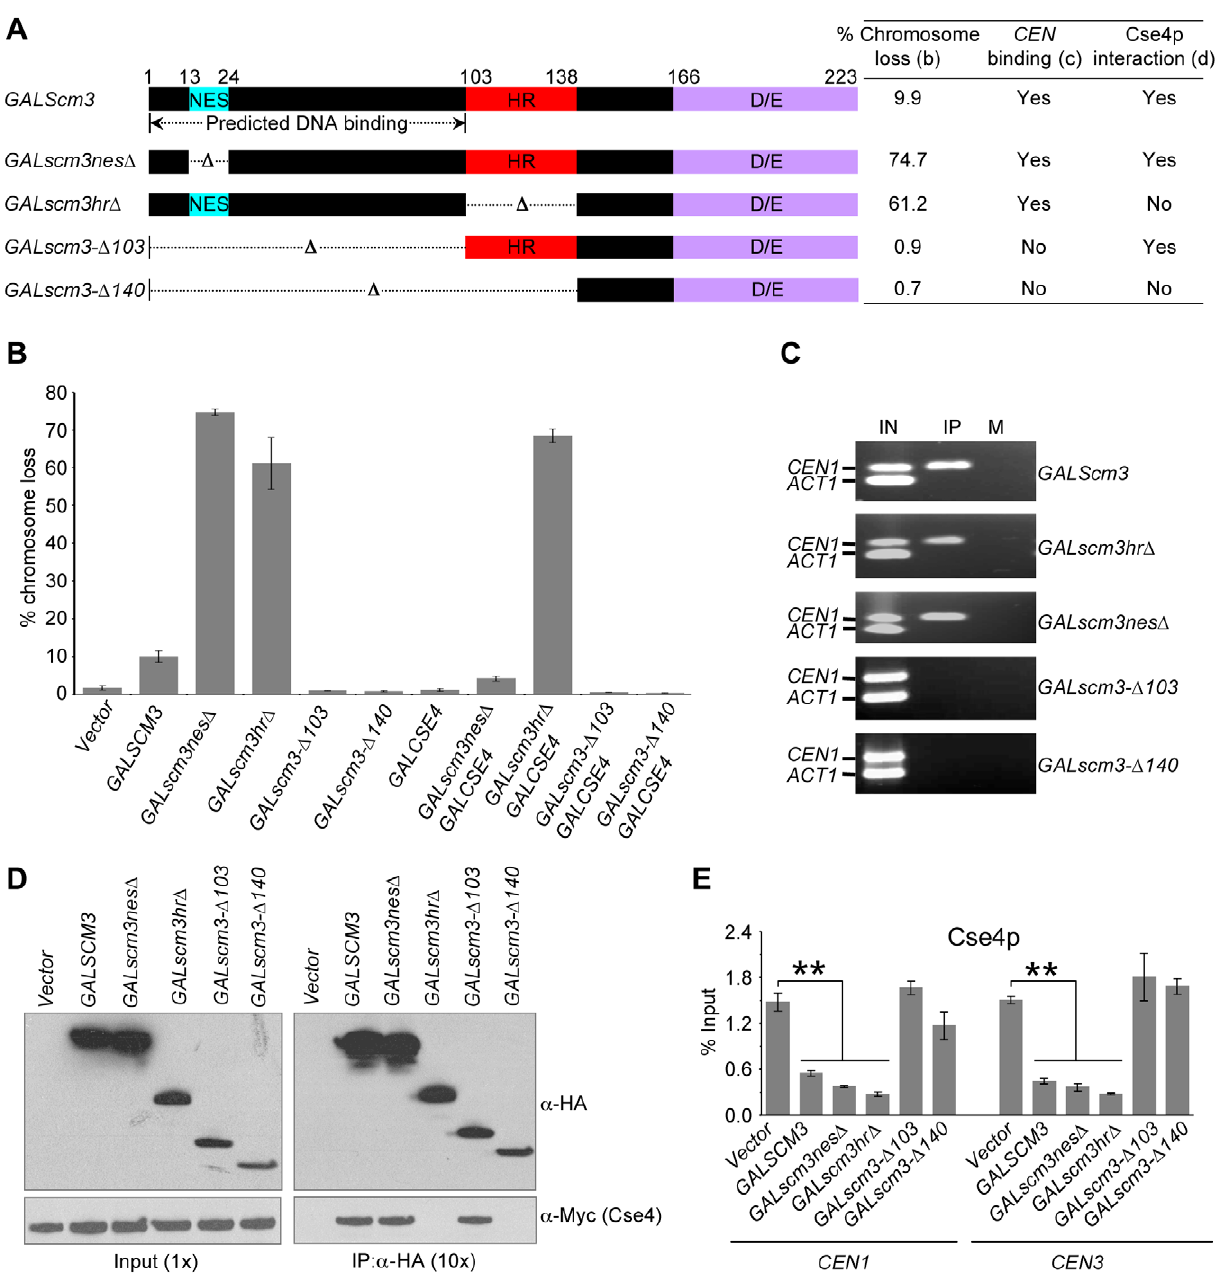
Figure 5. Scm3p can associate with CEN DNA independently of Cse4p, and the N-terminus of Scm3p mediates its centromeric association. (A) Schematic of full-length Scm3p and its allelic mutant proteins constructed using gene deletion approach. NES: nuclear export signal; HR: heptad repeat; and D/E: C-terminus acidic domain. Results from chromosome loss (B), CEN -binding (C) and Cse4p interactions (D) are summarized in the table. (B) Overexpression of N-terminal mutants ( scm3- D 103HA , scm3- D 140HA ) does not result in increased chromosome loss. Reporter strains with chromosome fragment (YPH1018) transformed with vector (pRS426 GAL1 ), GALSCM3HA (pMB1306), GALscm3nes D HA (pMB1393), GALscm3hr D HA (pMB1455), GALscm3- D 103HA (pMB1520), GALscm3- D 140HA (pMB1521), GALCSE4 (pMB1147), GALscm3nes D HA , GALCSE4 (pMB1393, pMB1147), GALscm3hr D HA , GALCSE4 (pMB1455, pMB1147), GALscm3- D 103HA , GALCSE4 (pMB1520, pMB976), GALscm3- D 140HA , GALCSE4 (pMB1521, pMB976) were assayed for chromosome loss as described in Figure 1 (C). (C) N-terminal mutants of Scm3 ( scm3- D 103HA , scm3- D 140HA ) do not bind CEN DNA. ChIP experiments were done using wild type strain (YMB6398 or JG595) with GALSCM3HA (pMB1306), GALscm3nes D HA (pMB1393), GALscm3hr D HA (pMB1455), GALscm3- D 103HA (pMB1520), GALscm3- D 140HA (pMB1521) grown in minimal media with galactose (2%) for 12 hours at 30 u C and immunoprecipitated with a -HA, and a -GST (mock) antibodies. Enrichment of Scm3p and its allelic mutant forms at CEN1 , and ACT1 (internal control) is determined by PCR. Lanes: IN (input), IP (DNA from chromatin immunoprecipitation using a -HA antibodies), and M (DNA from chromatin immunoprecipitation using a -GST antibodies). (D) Western blots of proteins copurifying with Scm3p or its allelic mutant forms. Extracts from cells coexpressing Myc-tagged Cse4p from its native promoter (Cse4-12Myc) and HA-tagged Scm3p or scm3 mutant proteins expressed from GAL1 promoter were used in immunoprecipitation (IP) experiments using anti-HA conjugated agarose beads. Eluted proteins were analyzed by western blotting with anti-HA and anti-Myc antibodies. Ten-fold more protein was loaded for IP samples. (E) Overexpression of Scm3p and its mutant alleles ( GALscm3nes D HA and GALscm3hr D HA ) cause reduction in Cse4p at centromeres. ChIP experiments were done using wild type strain